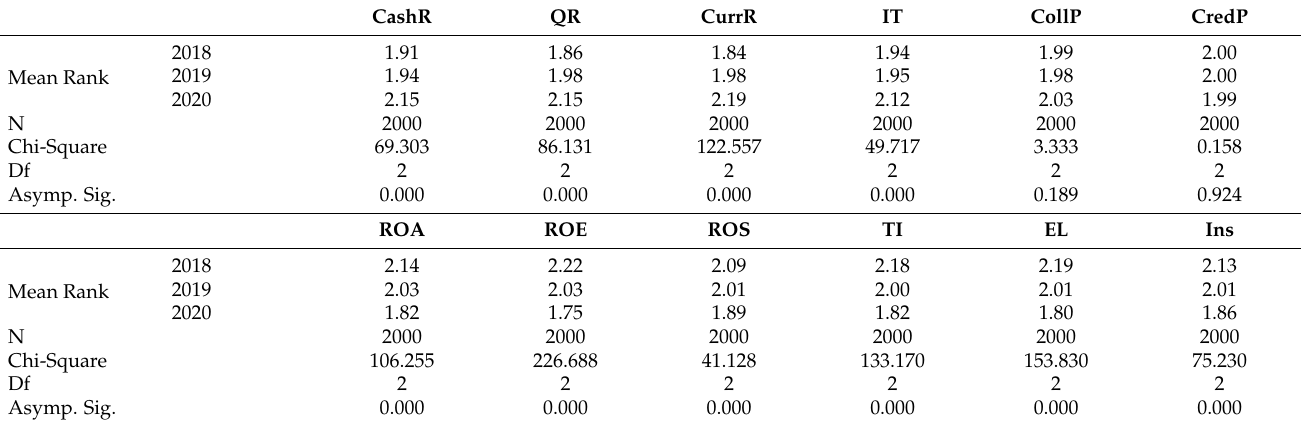
Table 8. The output of the Friedman